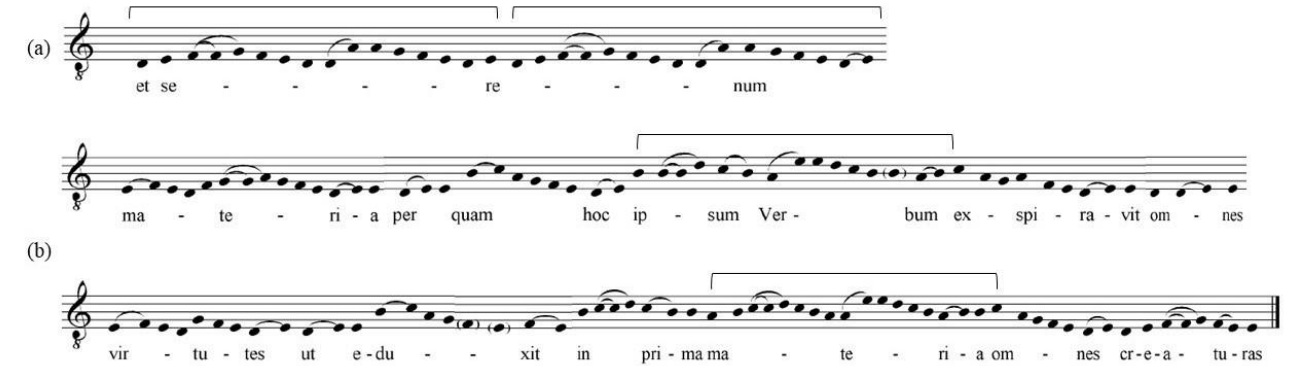
Figure 2. Phrases from O splendidissima gemma : ( a ) First two repetitions of phrase from line 2. ( b ) Lines 8–9, with transposed phrases from line 2 marked. Adapted according to Fassler (2022) from the transcription of Beverly R. Lomer/International Society of Hildegard von Bingen Studies.